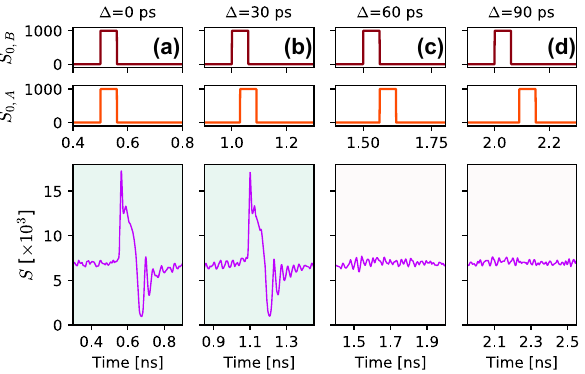
Figure 6: Numerical validation of the two-pulse coincidence detection task. Two positive square pulses encoded in the optical input signal trigger an excitable response in the PRL model only when both arrive into the node at the same ( Δ = 0 ps, (a)) or nearly the same time ( Δ = 30 ps, (b)). Pulse pairs with larger temporal separation (c, d) do not trigger an excitable response in the modelled nanoscale PRL